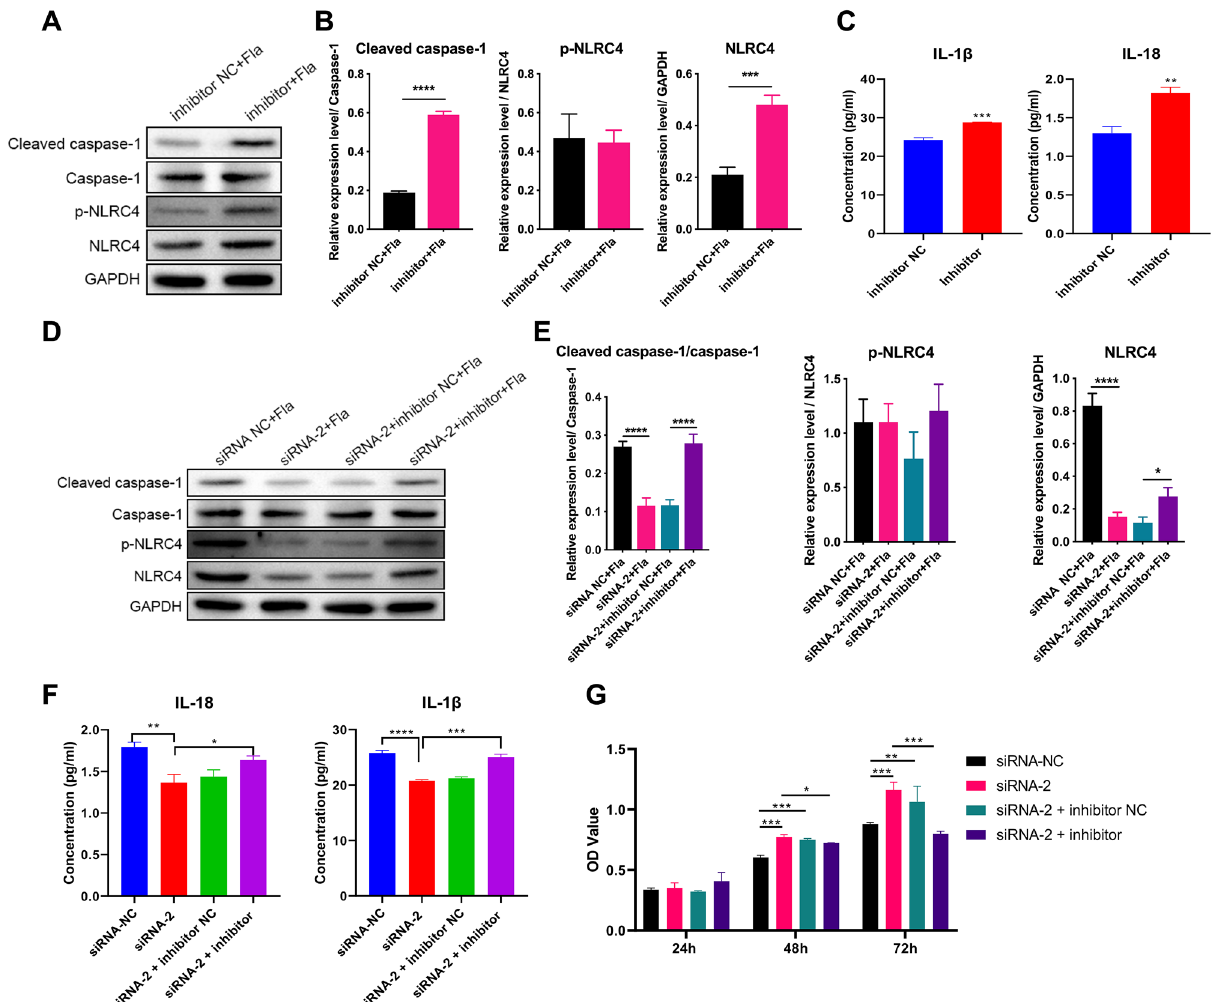
Figure 6. circ_0000181 participates in NLRC4-mediated pyroptosis by regulating miR-667-5p in MRTEC cells. ( A ) The WB analysis was used to evaluate the expression of NLRC4, p-NLRC4, and Caspase1 in MRTEC cells with Fla stimulation under miR-667-5p inhibitor interference. The origianl images were cut prior to hybridisation with antibodies during blotting. ( B ) WB results were further quantitatively analyzed. ( C ) The ELISA analysis was used to determine the secretion of IL-1β and IL-18 in MRTEC cells with Fla stimulation under miR-667-5p inhibitor interference. ( D ) The protein levels of NLRC4, p-NLRC4, and Caspase1 in MRTEC cells with Fla stimulation under siRNA-2 and miR-667-5p inhibitor interference were measured using WB analysis. The origianl images were cut prior to hybridisation with antibodies during blotting. ( E ) Quantitative analysis of WB results. ( F ) ELISA was used to assess the secretion of IL-1β and IL-18 in MRTEC cells with Fla stimulation under siRNA-2 and miR-667-5p inhibitor interference. ( G ) The MTS analysis was used to analyze the MRTEC cells’ proliferation ability with Fla stimulation under siRNA-2 and miR-667-5p inhibitor interference. * P < 0.05; ** P < 0.01; *** P < 0.001; **** P < 0.0001. Data are presented as the means ± SD from three independent